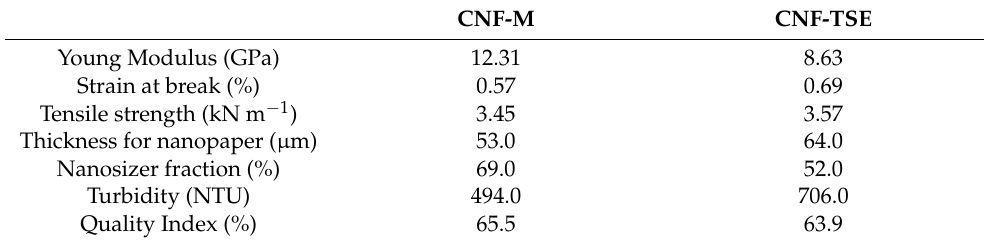
Table 2. Evaluation of the physical properties of the CNF